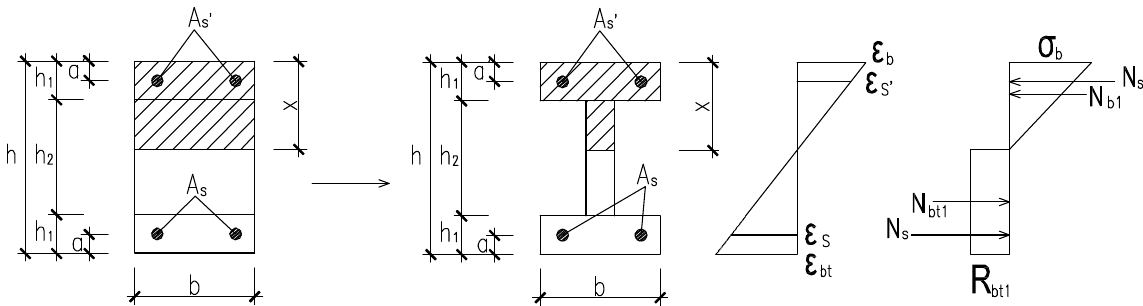
Figure 4. The calculation scheme A for the distribution of deformations, stresses, and forces in the three-layer with converting the composite section to the homogeneous section.